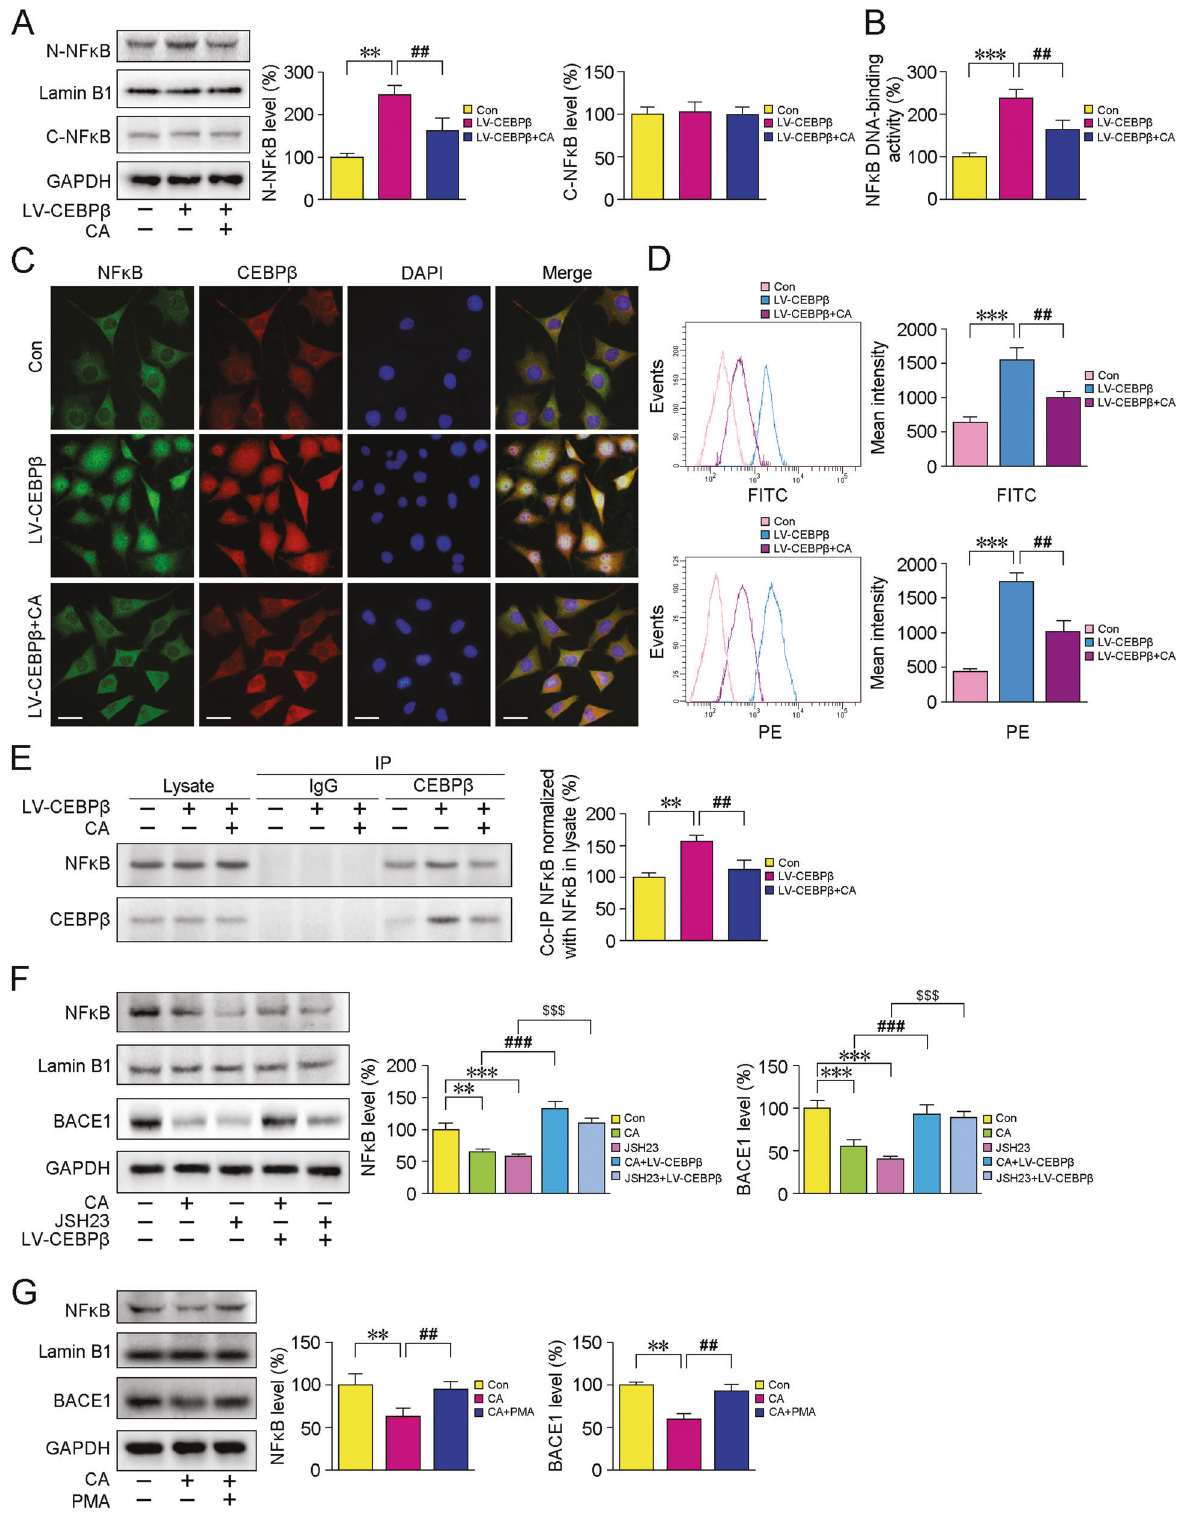
Fig. 8 CA-mediated inhibition of CEBP β /NF κ B signalling directly inhibits BACE1. A Representative blots of NF κ B p65 in SH-SY5Y cells following transfection with a lentiviral vector-encoding human CEBP β (LV-CEBP β ) or treatment with LV-CEBP β plus CA. B The DNA binding activity of NF κ B was determined by ELISA. C IF staining shows the NF κ B p65 (green) and CEBP β (red) protein expressions. Scale bars: 20µm. D FCM analysis of NF κ B p65 (FITC channel) and CEBP β (PE channel) after treatment with LV-CEBP β or LV-CEBP β plus CA. E The binding of CEBP β to NF κ B was examined by Co-IP. F Similar to JSH-23, CA treatment-induced decreases in nuclear NF κ B p65 and cytosolic BACE1 expressions were blocked by LV-CEBP β . G CA- mediated inhibition of BACE1 was diminished by the NF κ B activator, PMA. The data were representative of at least three independent experiments. ** p <0.01 and *** p <0.001 vs the controls; ## p <0.01 vs the LV-CEBP β -treated group ( A – E ). ** p <0.01 and *** p <0.001 vs the controls; ### p <0.001 versus CA-treated group; $$$ p <0.001 versus JSH-23 treatment group ( F ). ** p <0.01 vs the controls; ## p <0.01 vs the CA treatment group ( G ). Data were analysed using one-way ANOVA and Fisher LSD post hoc tests. Values represent the mean±SD of at least three independent experiments. Cell Death and Disease (2022)